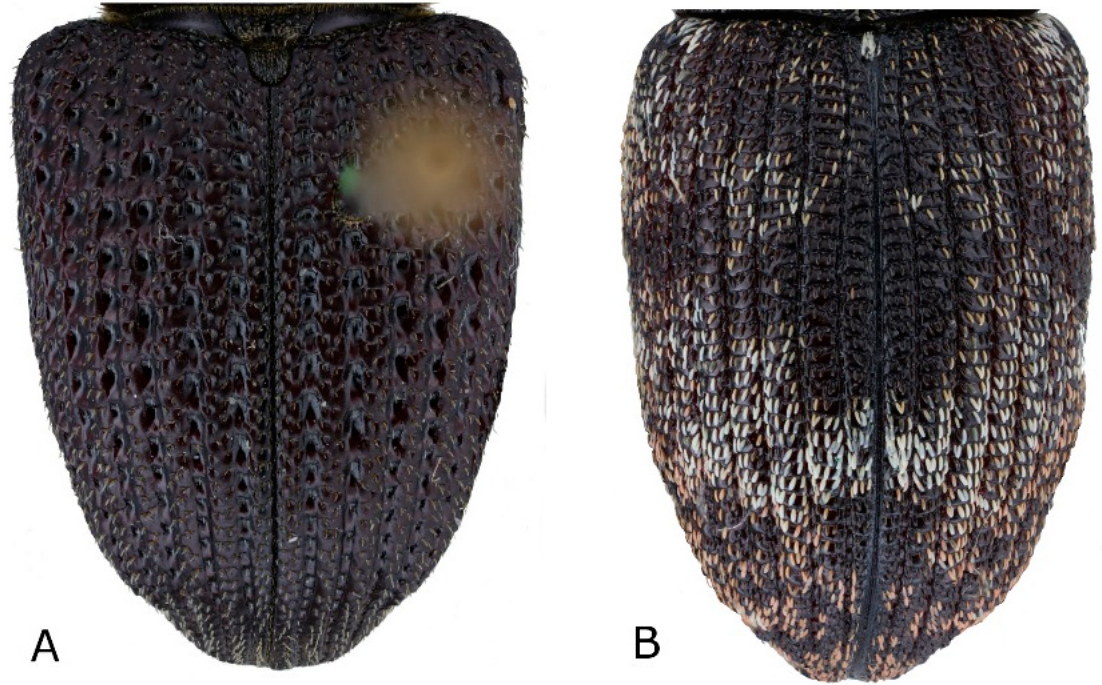
1. Striae with large elongate foveae; interstriae lacking regular transverse creases (Figure 4A); hind tibia more than twice as long as maximum width, not strongly curved posteriad, anterior margin revealing internal flange (Figure 6C) . . . . . . . . . . . . . . . . . . . . . . . . . . . . . . . . . . . . . . . . . . . . . . . . .2 - Striae with no large foveae, interstriae with more or less regular transverse creases, giving an appearance of rectangular blocks (Figure 4B); hind tibia less than twice as long as maximum width, strongly curved posteriad, internal flange concealed by anterior margin (Figure 15B) Angola . . . . . . . . . . . . . . . . . . . . . . . . . . . . . . . . . . . . . . . . . . . . . . . . . Sclerocardius kuscheli sp. nov. 2. Scales on pronotum absent, setiform or, if present and broader, less or only slightly longer than diameter of basal puncture and not or only just projecting above it (Figures 1A and 10A). Male with single small rounded tooth projecting from postero-ventral side of fore tibia (Figure 6A) (none in female). Africa, Madagascar. . . . . . . . . . . . . . . . . . . . . . . . . . . . . . . . . . . . . . . . . . . . . . . . . 3 - Scales on pronotum and elytra bright orange, many at least twice as long as the diameter of the basal puncture and almost all projecting beyond it (Figure 19A). Male with several small rounded teeth projecting from postero-ventral side of fore tibia (Figure 20B) (none in female). Sumatra . . . . . . . . . . . . . . . . . . . . . . . . . . . ... . . . . . . . . . . . . . . . . ( Sclerocardius indicus Hartmann ) 3. Pronotum punctate on disc, posteriorly punctures sometimes confluent and separated by raised irregular transverse ridges (Figure 1); penis body three-quarters the length of its apodemes, penis body length more than 2.6 times its maximum width (Figure 8D) Africa. . . . . . . . . . . . . . . . . . . . . . . . . . . . . . . . . . . . . . . . . . . . . . . . . . Sclerocardius africanus (Boheman) - Pronotum with raised irregular ridges between punctures posteriorly and extending onto disc (Figure 10A); penis body half the length of its apodemes, penis body length not more than 2.1 times its maximum width (Figure 13D) Africa, Madagascar. Sclerocardius bohemani Schoenherr